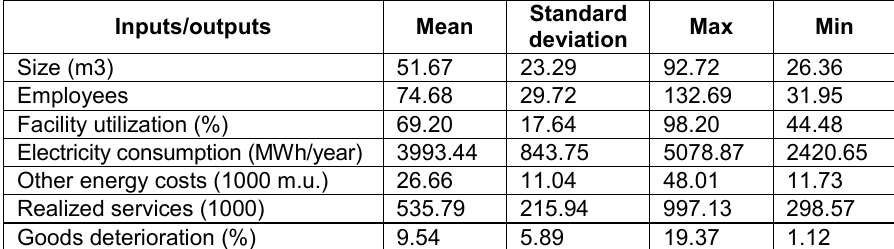
Descriptive statistics for the inputs and outputs in refrigerated warehouses